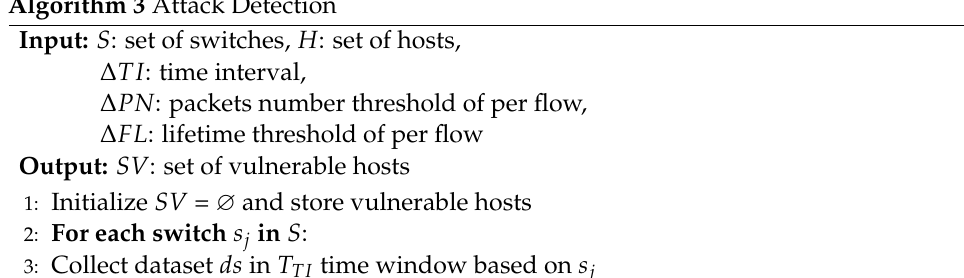
Algorithm 3 Attack